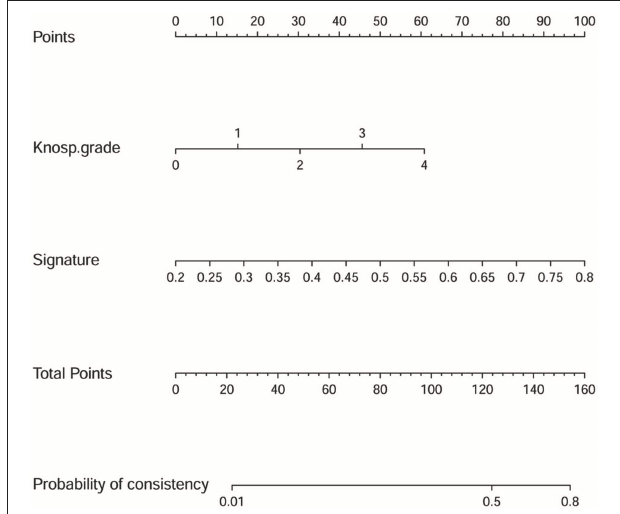
FIGURE 5 | Nomogram derived from the radiomics model applied to the primary cohort. The radiomics model was incorporated with the Knosp grade and radiomics signature. This nomogram is used according to the patient’s Knosp grade and radiomics signature value. The position of each variable is found on the corresponding axis (lines 2 and 3), and a vertical line is then drawn to the points axis (the first line) to obtain the corresponding score. As an example, one patient in this study with a Knosp grade of 3 had a score of 45.6, and his radiomics signature value was 0.28, which means a score of 13.0. Next, according to the sum of all scores, the position on the total points axis is identified, and a vertical line is drawn from the position to the last line to determine the tumor consistency possibilities. The above-mentioned patient’s total risk score was 58.6, which corresponds to a 2.4% probability of a firm tumor. That is to say, using our nomogram, this patient’s tumor consistency was predicted to be soft before surgery. Later, this patient’s clinical and surgical data indicated that the tumor was indeed soft. Thus, the model accurately predicted this patient’s tumor